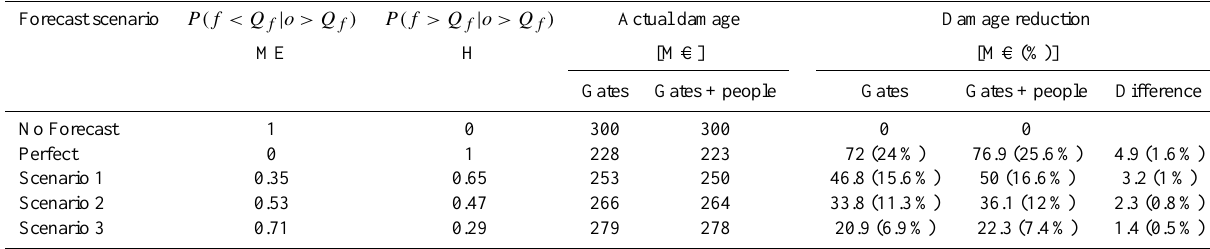
Table 3. Potential damage considering forecasting errors for the hazard scenario Q = 170m 3 s − 1 . Forecast scenario